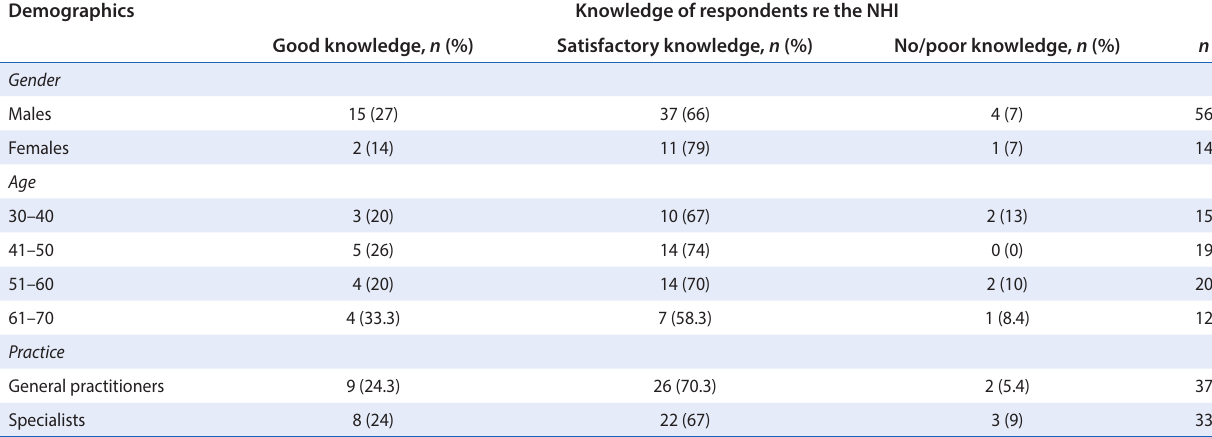
Table 1: Respondents’ knowledge of NHI according to gender, age and practice ( n = 70) Demographics